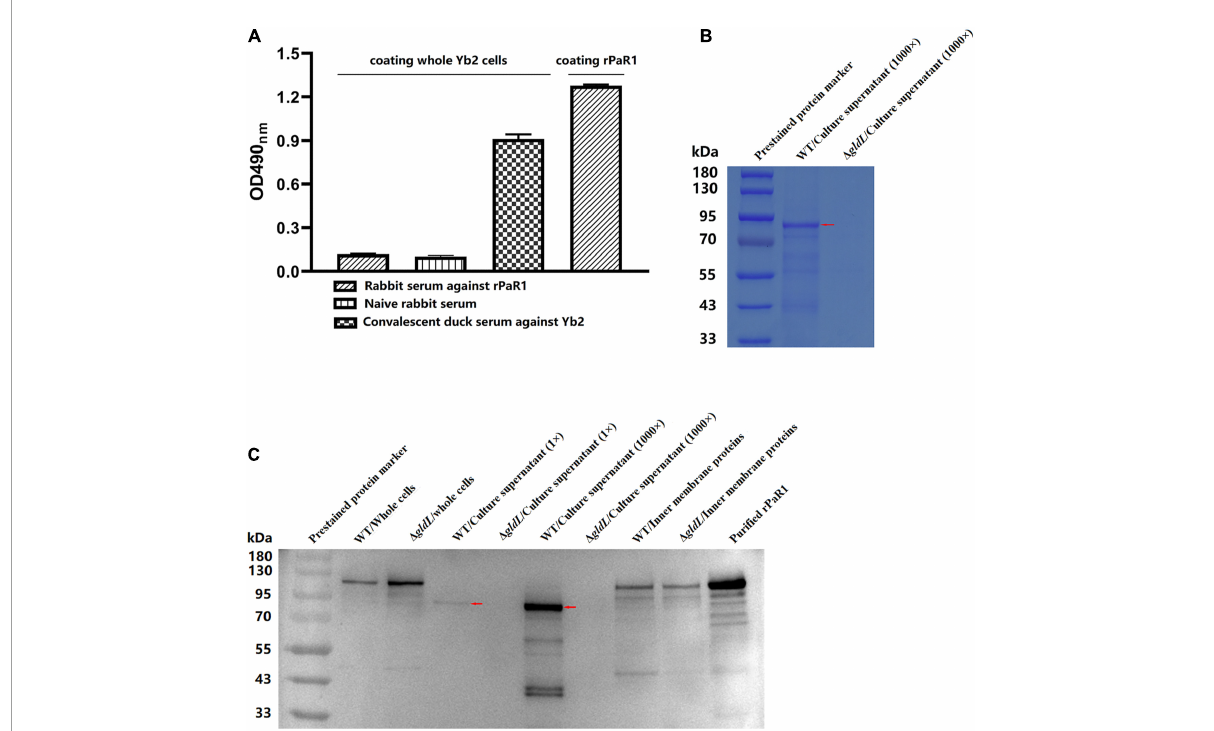
FIGURE3 PaR1 protein localizes to the culture supernatant of R. anatipestifer . (A) Polyclonal antibodies against rPaR1 in immunized rabbit serum did not react with whole Yb2 cells in a whole-cell ELISA. (B) Protein secretion was defective in T9SS-defective mutant (cid:49) gldL . R. anatipestifer cells were grown in TSB medium at 37 ◦ C with shaking and harvested in exponential phase (OD 600 = 1.0). The cells were removed by centrifugation and filtered (0.22 µ m). Equal volumes of cell-free culture supernatant of wild-type Yb2 (WT) and (cid:49) gldL mutant were precipitated with TCA (concentrated 1,000-fold), and the proteins were separated with SDS-PAGE and stained with Coomassie Brilliant Blue G-250. The red arrow indicates the position of the main component in the trichloroacetic acid (TCA)-precipitated proteins from the culture supernatant of wild-type Yb2. (C) Mature PaR1 was detected with western blotting using rabbit antiserum against rPaR1 in the culture supernatant of wild-type Yb2, but not in that of T9SS-defective mutant (cid:49) gldL . R. anatipestifer cells were grown in TSB medium at 37 ◦ C with shaking and harvested in exponential phase (OD 600 = 1.0). Equal volumes of cultured WT and (cid:49) gldL were used to prepared the whole cells, and inner membrane proteins. Proteins from equal volumes of cell-free culture supernatant of wild-type Yb2 (WT) and (cid:49) gldL mutant were precipitated with TCA